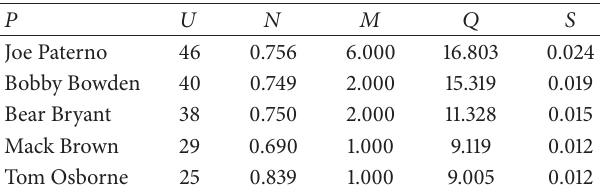
Table 13: Comparison of priority (football).